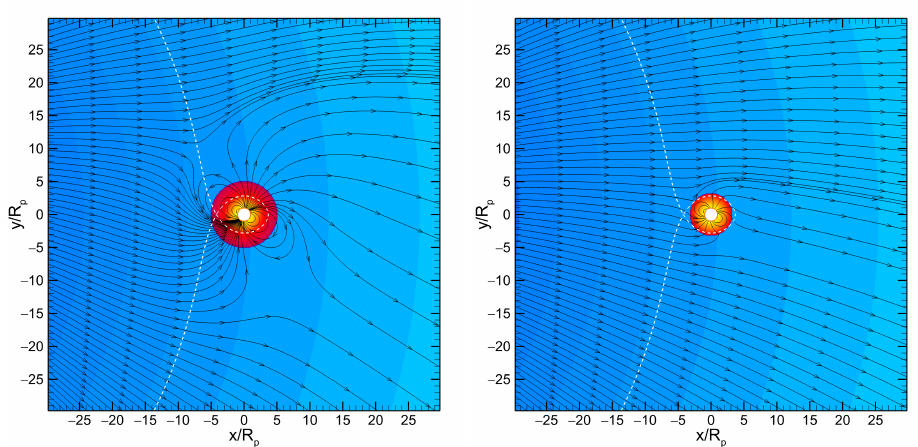
Figure 8. The initial distributions of density (color) and magnetic field (lines with arrows) for the case, when the temperature of the atmosphere T a = 6000 K, and the magnetic field at the stellar surface B s is 0.01 G (left) and 0.5 G (right). The dotted line shows the boundary of the Roche lobe. The white circle corresponds to the photometric radius of the